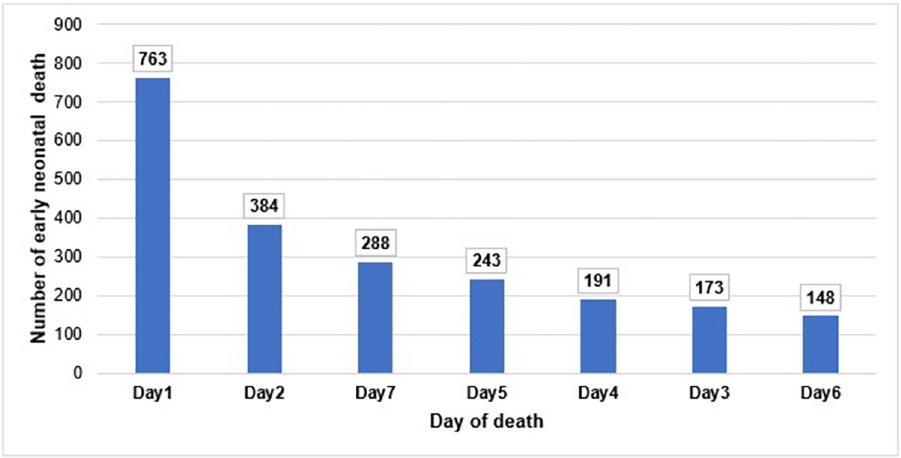
Fig 1. Distribution of early neonatal death by the day of stay after birth in Ethiopia,2021.